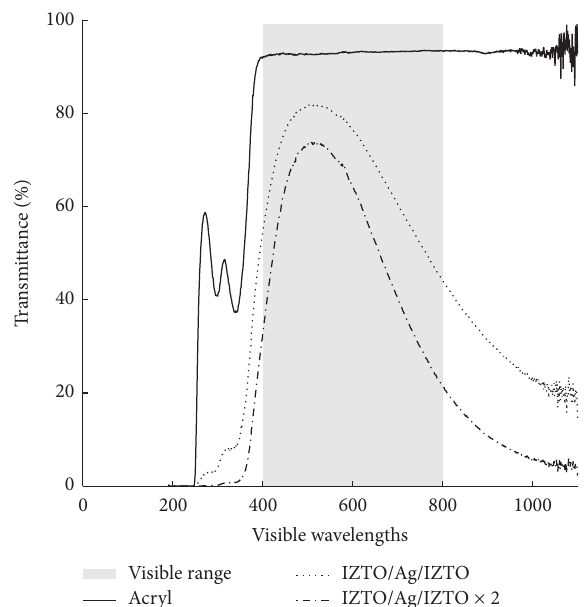
Figure 4: Transmittance of the transparent conductive film on the acryl substrate.